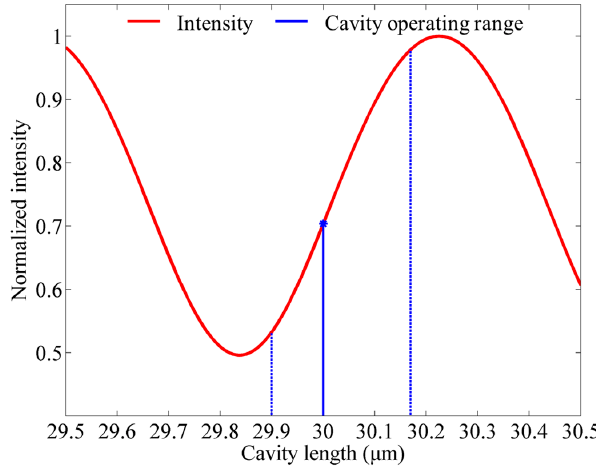
Figure 2. Intensity response of Fabry–Perot (FP) cavity.